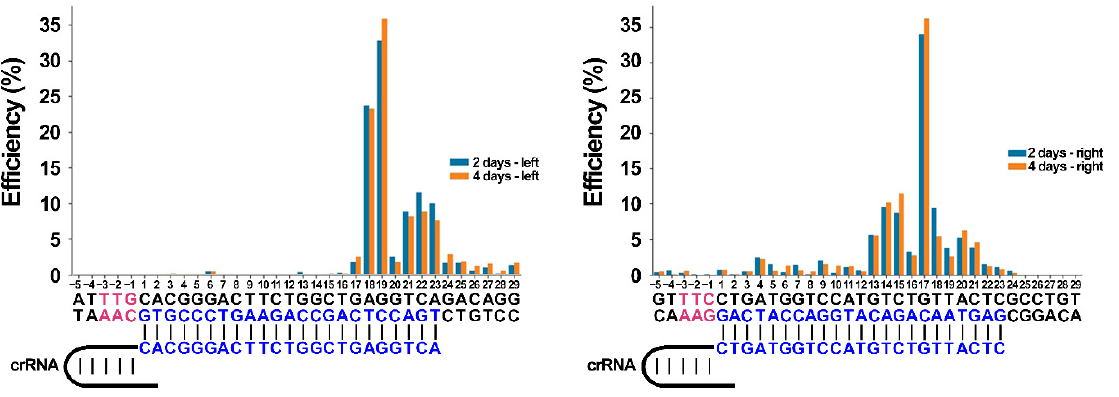
Figure 10. Frequencies of break site flanking deletion. On the left side of the figure, a crRNA is indicated, which, complexed with RbCas12a, forms break sites flanking the left arm of the deletion. On the right side of the figure, the right crRNA is indicated. PAM sequences on both target and nontarget strands are highlighted in red font. The protospacer position on the target DNA strand and spacer moiety of crRNA is highlighted in blue font. Relative coverage depth in the edited region was calculated as depth coverage in certain positions divided by mean coverage depth outside of the edited region. DNA break efficiency after a certain position was assessed as the difference between relative depth in two neighboring positions.